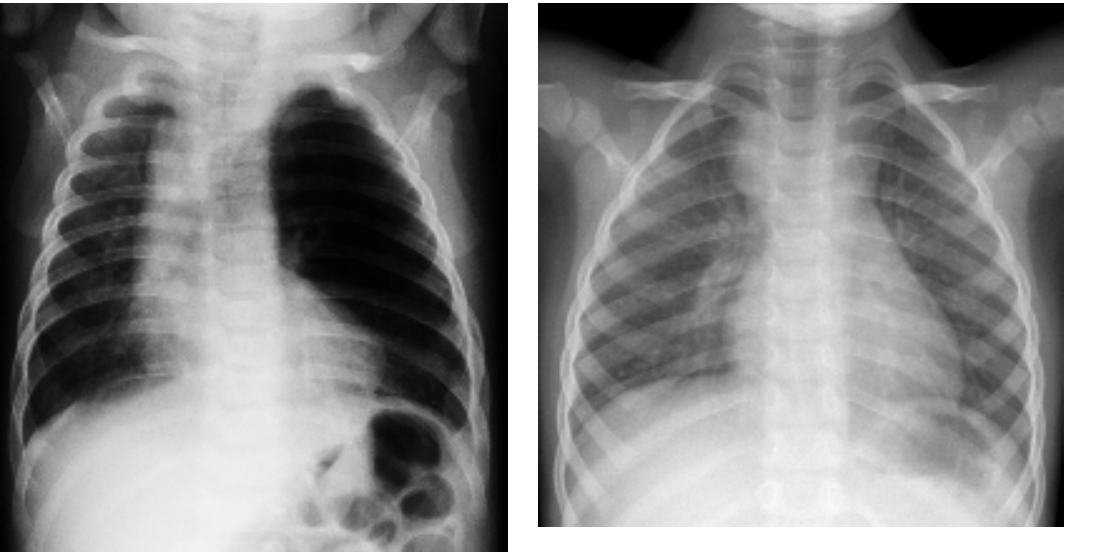
Bronchogenic cyst. Chest radiograph of a 2-year-old girl with a bronchogenic cyst projecting from the mediastinum. The typically rounded paratracheal mass with uniform density was found incidentally, and the girl was asympto-